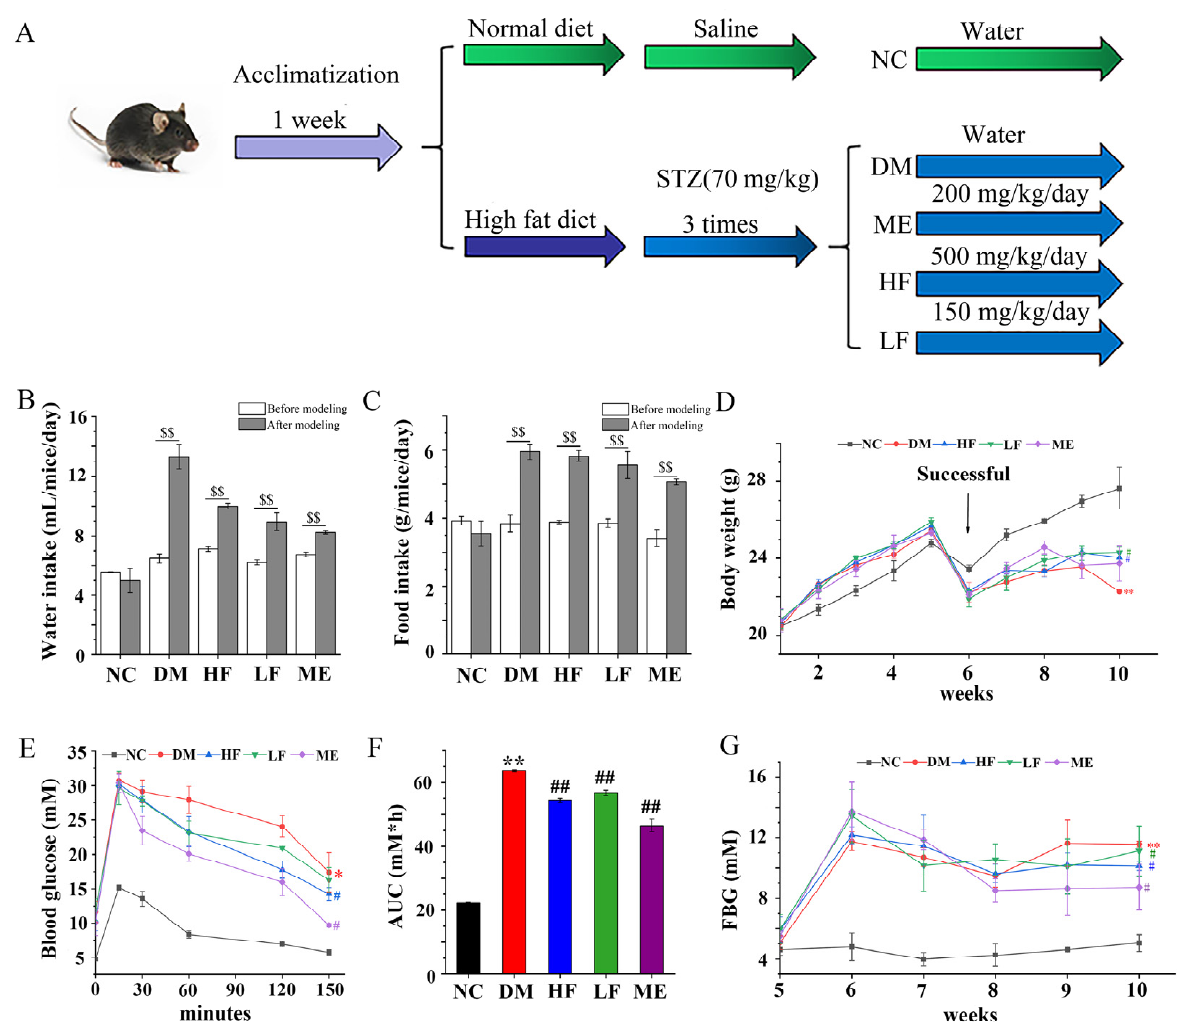
Figure 1. Effect of LJF on T2DM symptoms: process diagram of the mice experiment ( A ); intake of food ( B ) and water ( C ), $$ p < 0.01, before and after modeling; body weight ( D ); blood glucose levels ( E ) and AUC ( F ) in the OGTT; FBG ( G ). * p < 0.05 and ** p < 0.01 vs. NC group, and # p < 0.05 and ## p < 0.01 vs. DM group.